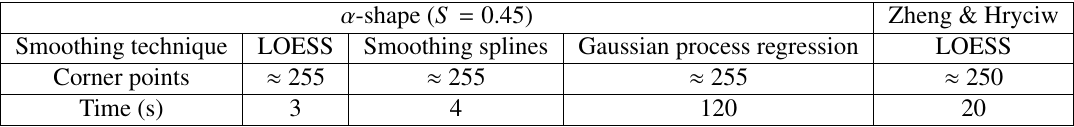
Table 1: Computational time for roundness of the sand particle shown in figure 5 α -shape ( S = 0 . 45) Zheng & Hryciw Gaussian process regression